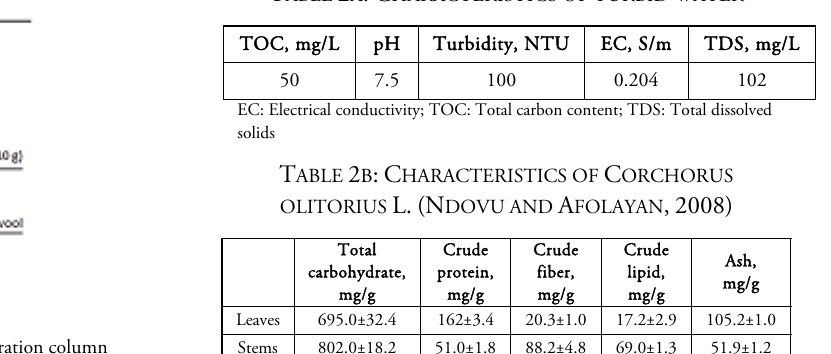
Fig.1. Schematic diagram of the filtration